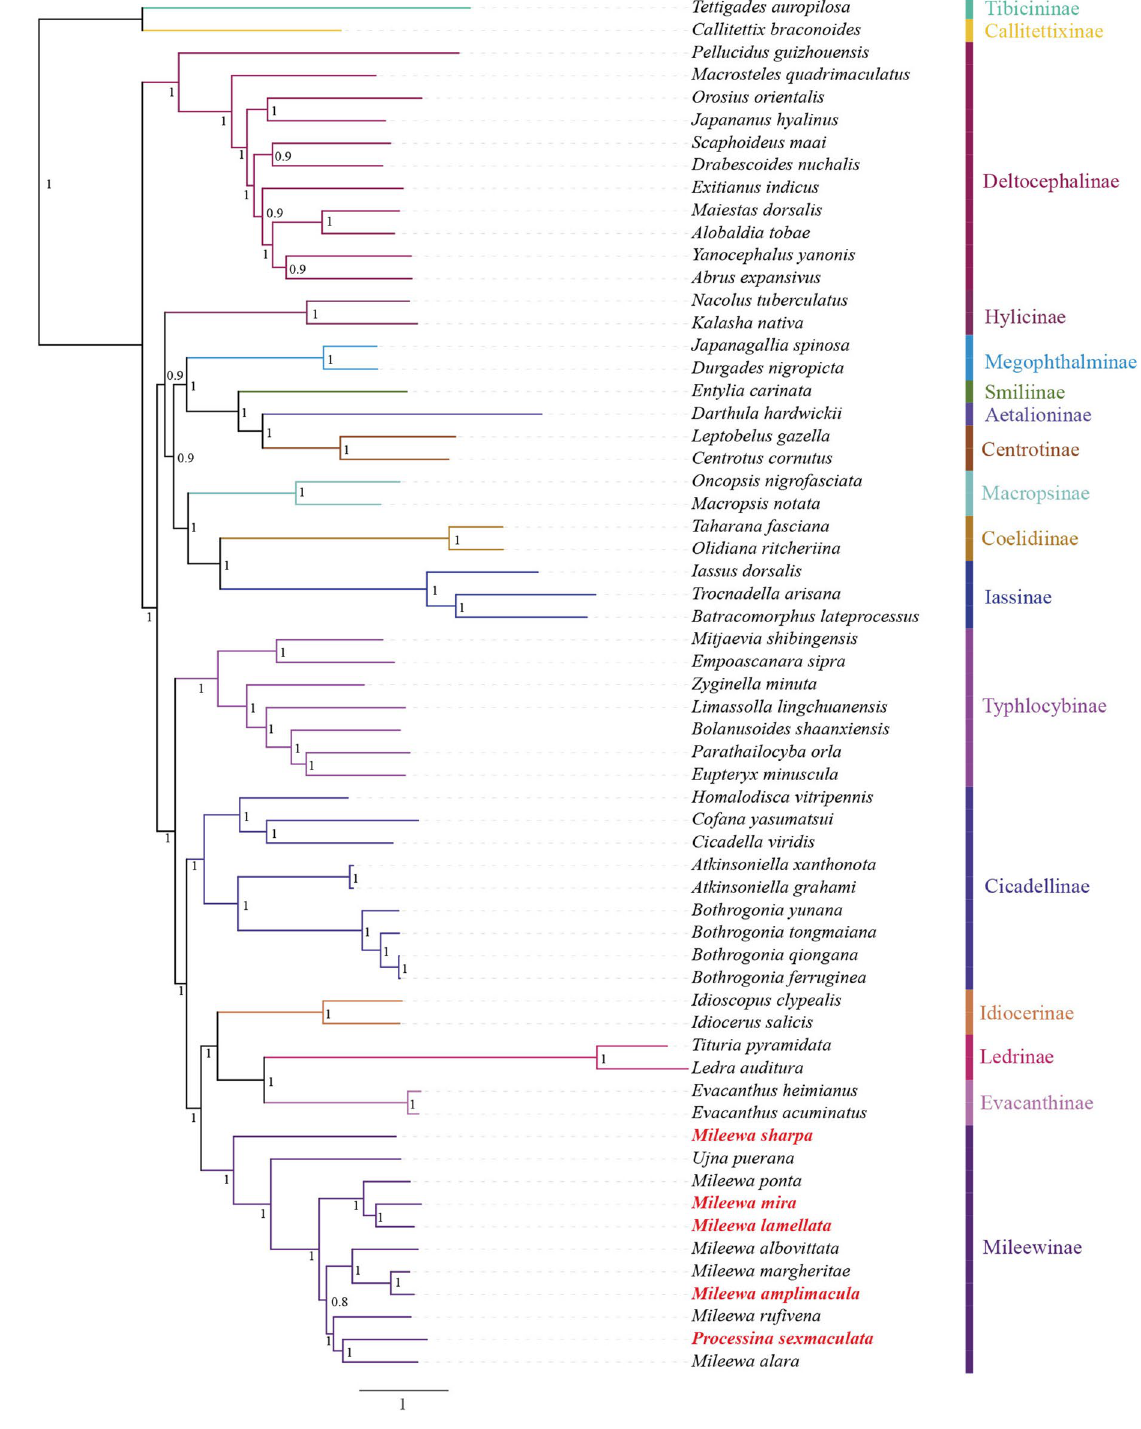
Figure 4. Bayesian inference (BI) phylogenetic tree analysis of 13 protein-coding genes (PCGs). Callitettix braconoides and Tettigades auropilosa are outgroups. Posterior probability (PP) values are shown at the nodes. Newly sequenced mitogenomes are indicated in